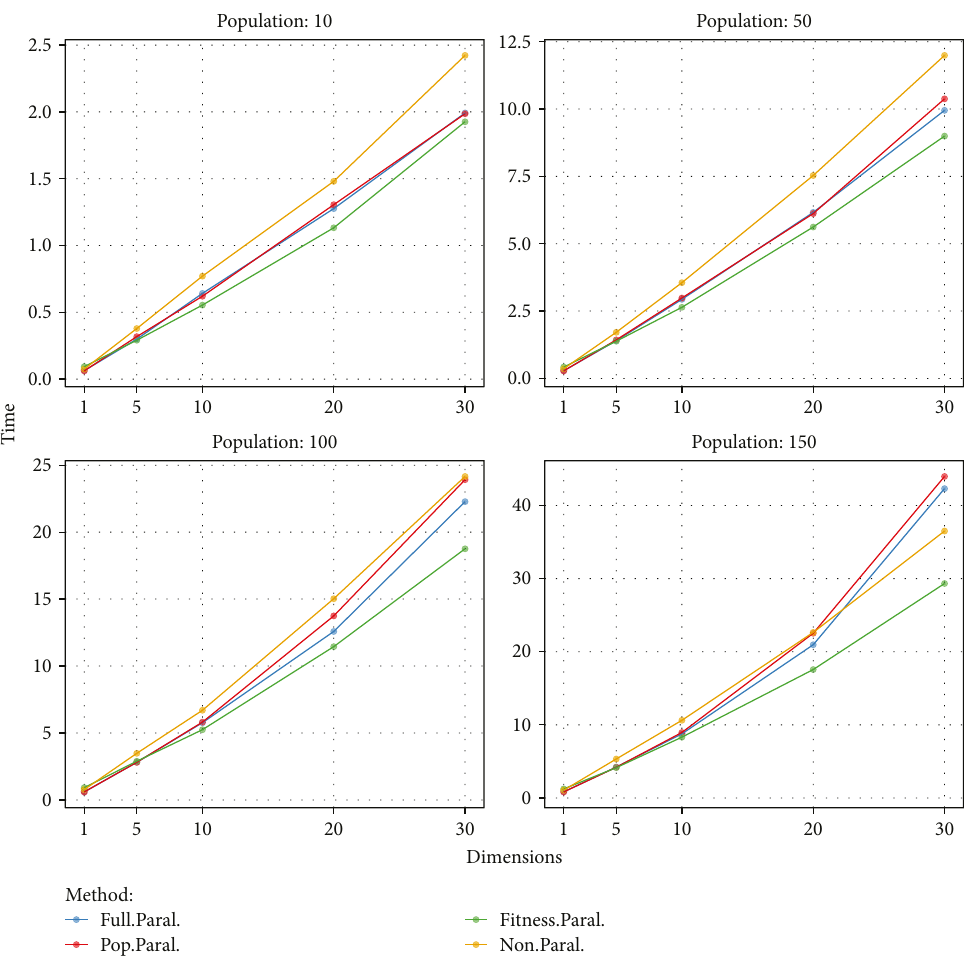
Figure 4: Parallel runs with M3GP, time (in minutes) versus